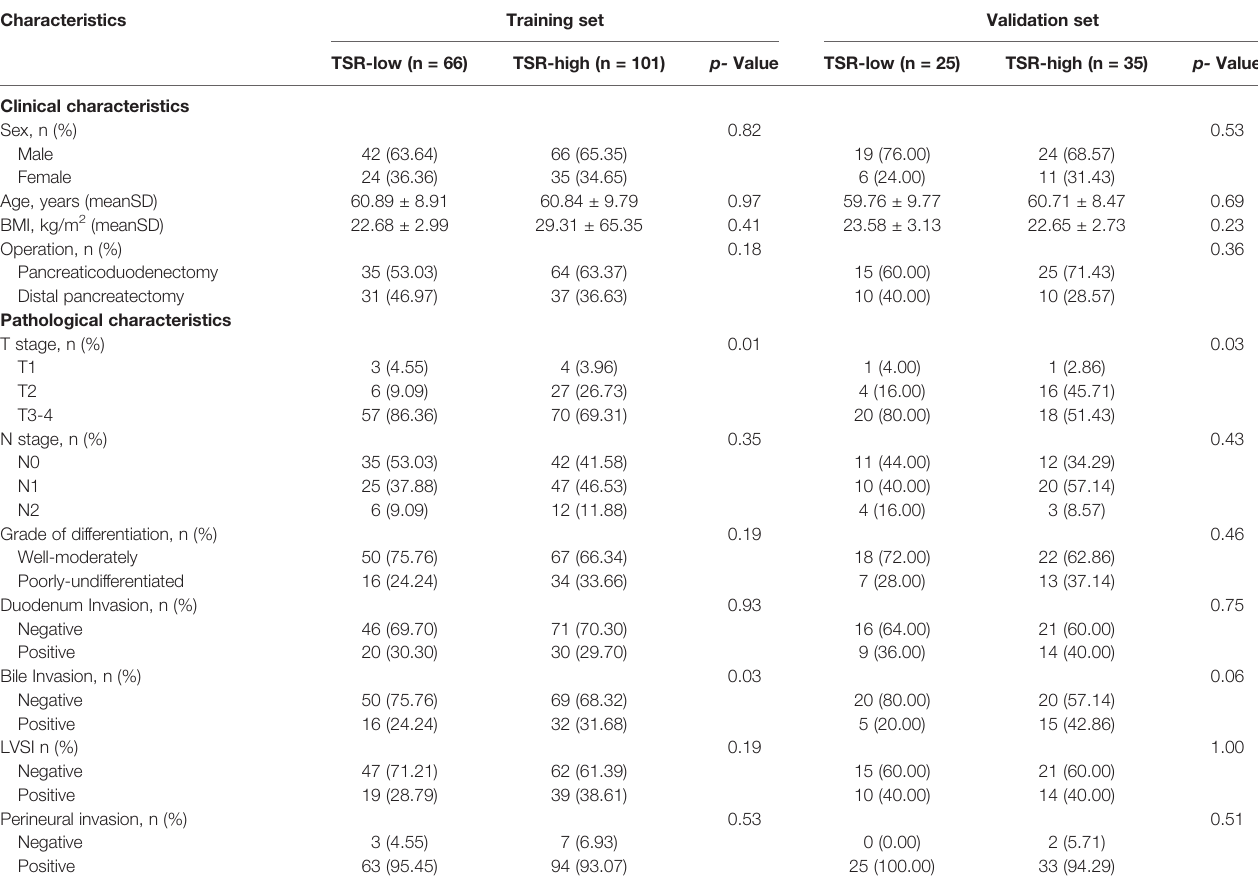
TABLE 1 | Baseline characteristics of patients with pancreatic